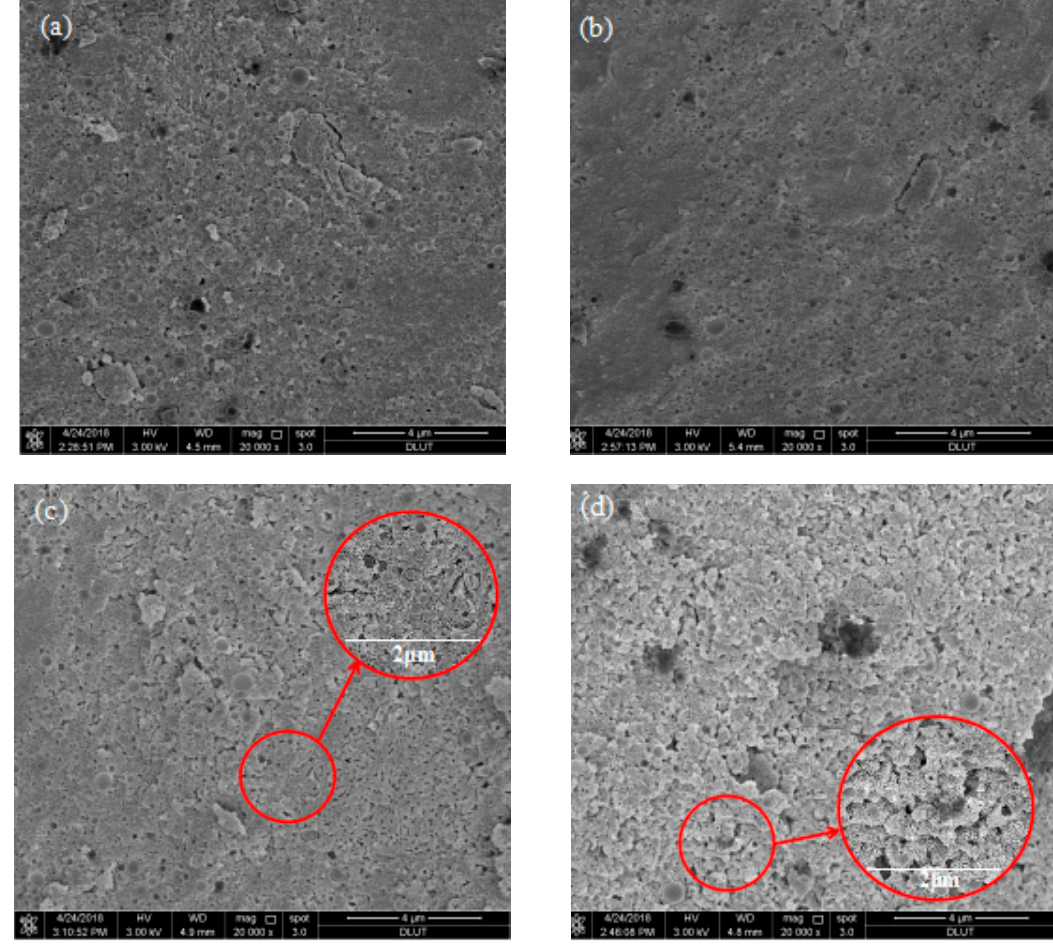
Figure 8. Scanning electron microscopy (SEM) of hydrated products with different Cs + contents after 28 d: ( a ) 0%; ( b ) 0.4 wt %; ( c ) 0.8 wt %; and ( d ) 1.6 wt %. Table 4. Leaching rate and cumulative leach fraction of the M–S–H cement-solidified body with 0.8 wt. % Cs under di ff erent leaching